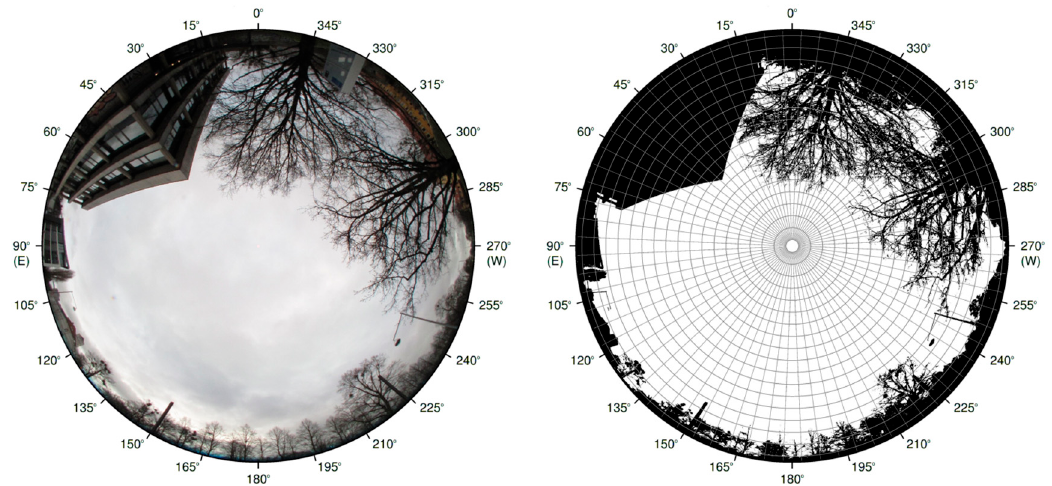
Figure 1. Hemispherical image taken in front of the Institute of Meteorology and Climatology of the Leibniz Universität Hannover ( left ) and the image with the derived obstruction information ( right ), where the derived obstructions shadowing the sky are shown in black and sky in white. The image is segmented by the grid shown, which illustrates the different directions (sky segments). The ratio of the amount of pixels characterized as obstructions and the total pixel count results in 39% obstructed sky.